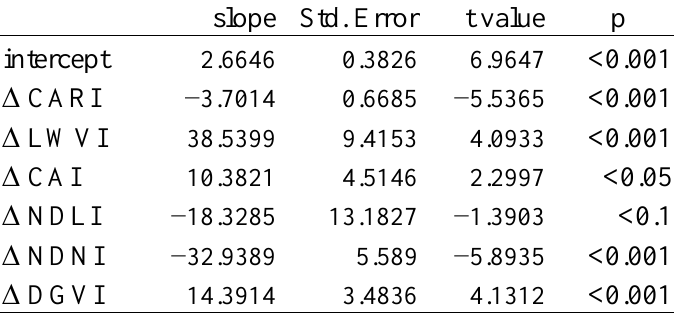
Table 2. Regression coefficients of the final partial linear model. slope Std.